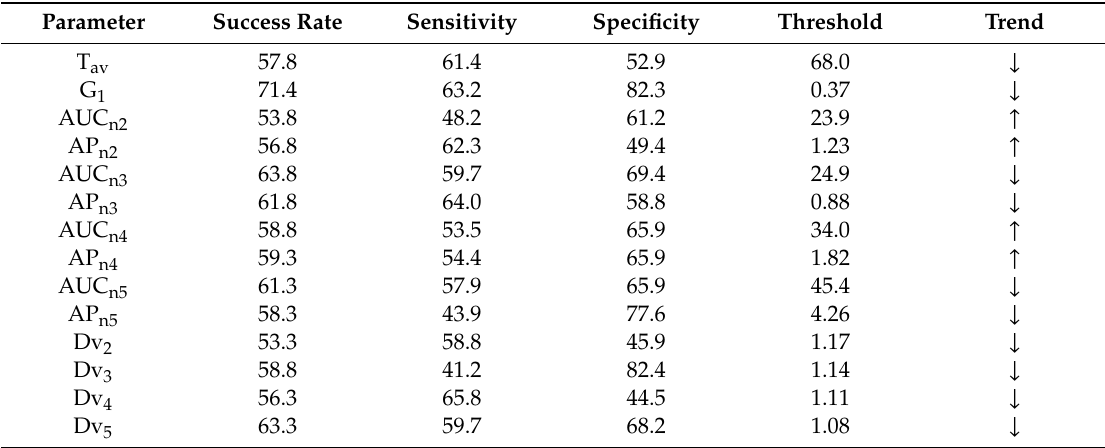
Table 2. Receiver Operating Characteristic (ROC) analysis for individual thermal liquid biopsy (TLB)- derived